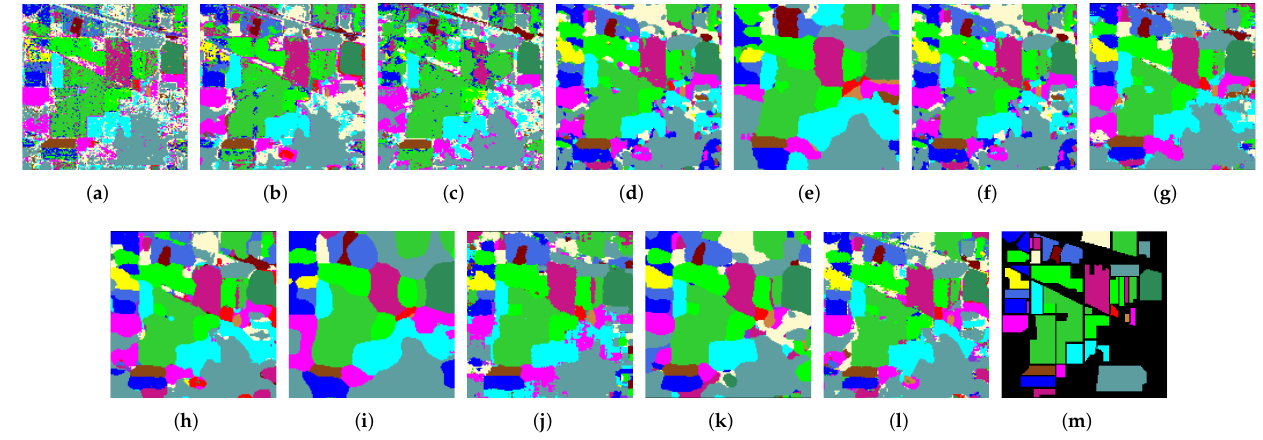
Figure 8. Classification maps for the IN data set obtained by ( a ) SVM, ( b ) CDCNN, ( c ) 3DCNN, ( d ) SSRN, ( e ) DFFN, ( f ) MFDN, ( g ) CBW, ( h ) FGSSCA, ( i ) LDN, ( j ) S2FEF, ( k ) S3EResBoF, ( l ) LMFN, and ( m ) Ground truth.